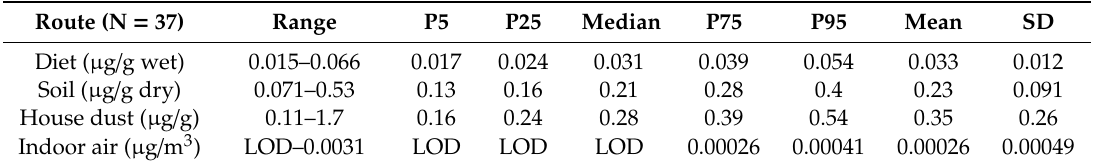
Table 5. Summary on Se concentrations according to the exposure